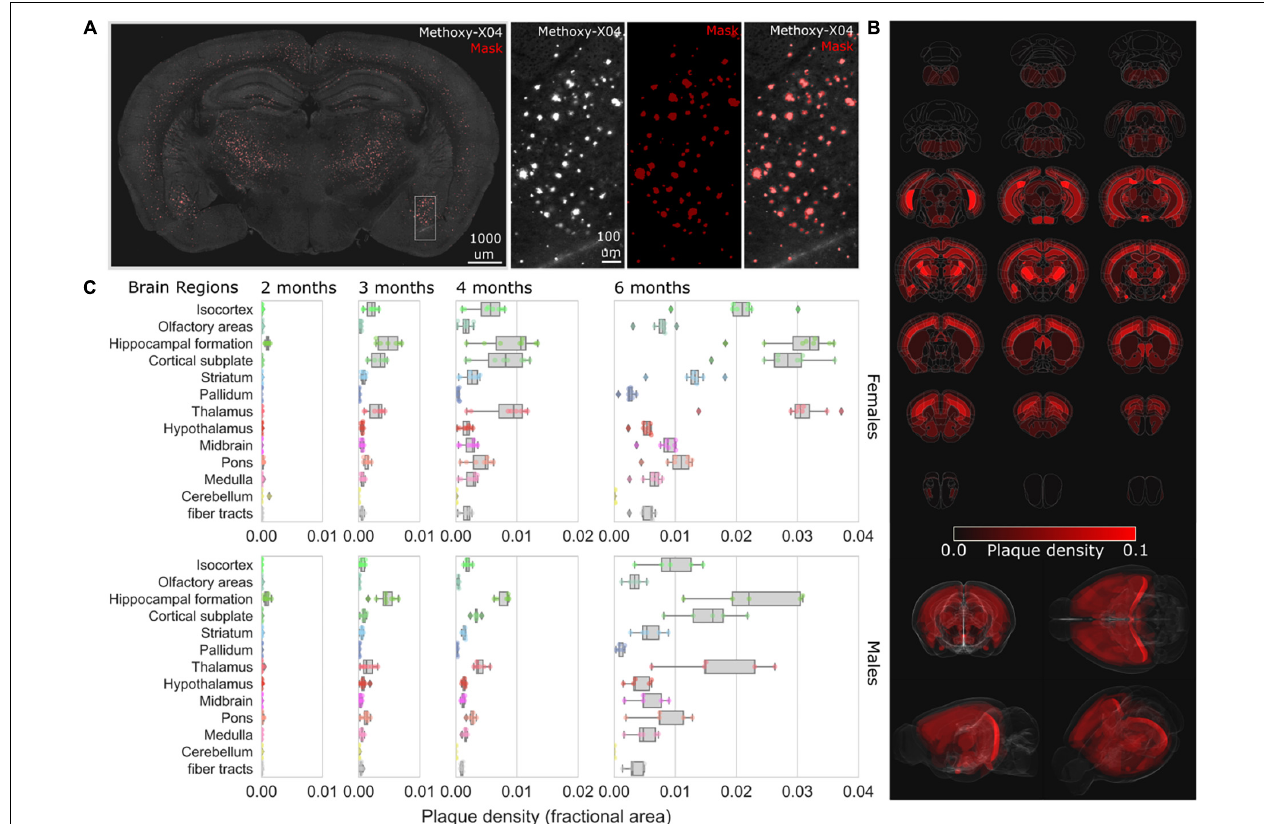
FIGURE 5 | Mapping the progression of methoxy-X04 labeled plaque deposition across brain regions. (A) Example brain section from 4-month-old female 5XFAD with methoxy-X04 labeled (gray) and segmentation masked plaques (red overlay). Zoom inset depicts (left to right) methoxy-X04 signal, mask (red), methoxy-X04 signal with mask overlay. (B) Plaque densities (fractional area) were quantified for all brain regions depicted as average density heat maps (red) mapped across the entire Allen Mouse Brain Reference Atlas for 6-month-old female 5XFAD, visualized as evenly spaced selected coronal sections (top) and 3D renderings (bottom). (C) Box plots of the plaque densities for 13 major brain regions from 2-, 3-, 4-, and 6-month-old female (top) to male (bottom) cohorts demonstrate regional plaque density progression, plots depict median and interquartile range (IQR-25:75) whiskers depict 1.5 × IQR, and diamonds for values outside the